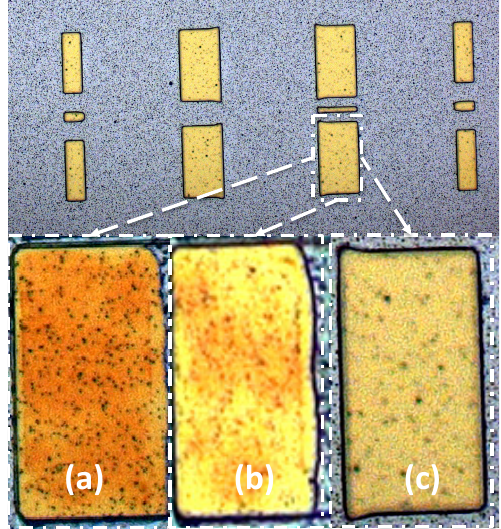
Figure 15. ( a ) The Al-Au compounds observed ( b ) Al-Au compounds are reduced with 50 nm chromium barrier layer applied between the gold and aluminum layer ( c ) 80 nm chromium barrier layer prevented Al-Au to